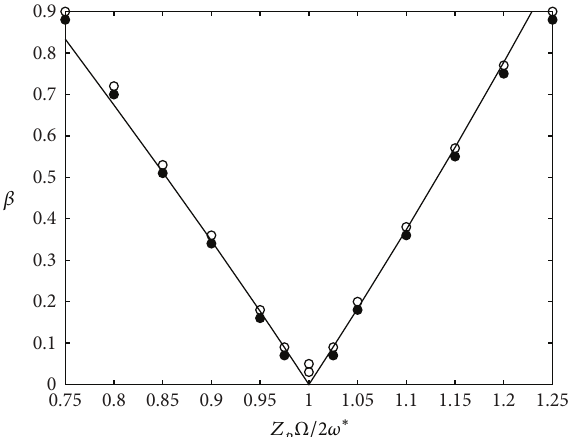
Figure 4: Dynamic instability region of a rotating ship shaft with = 3 . Key as for Figure 3. 𝑍 𝑝